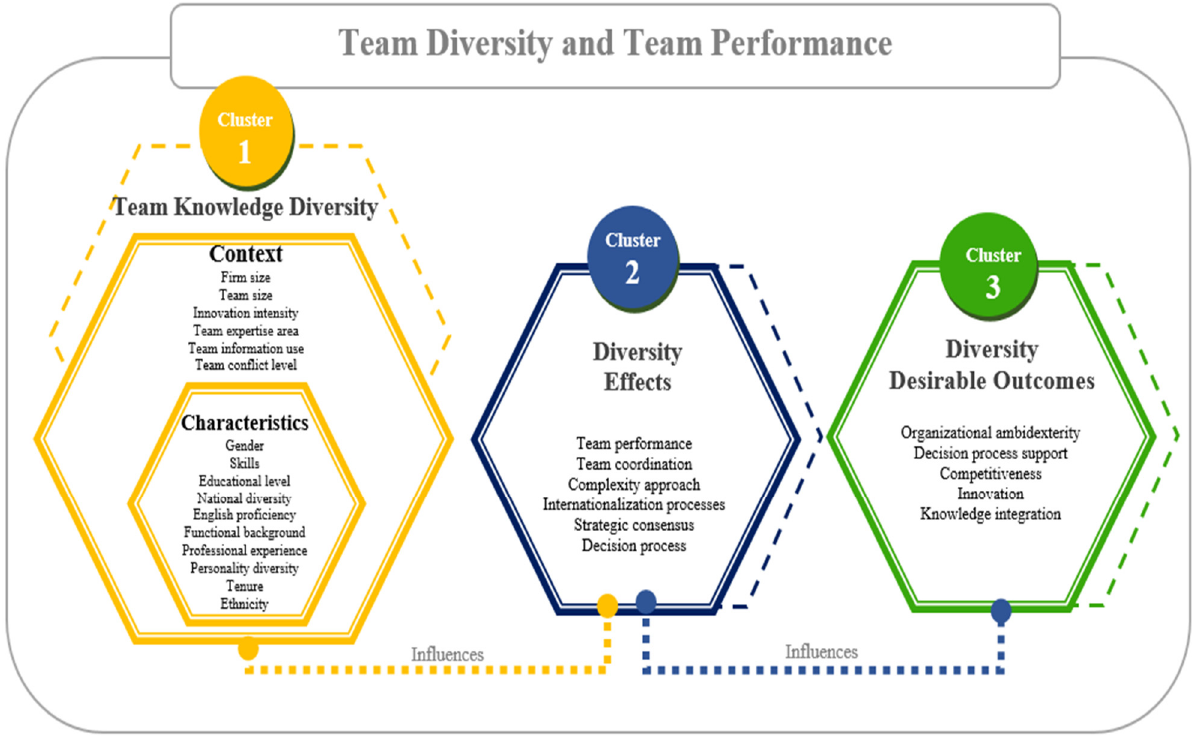
Figure 4. Hypothesized framework for Team Diversity analyses.